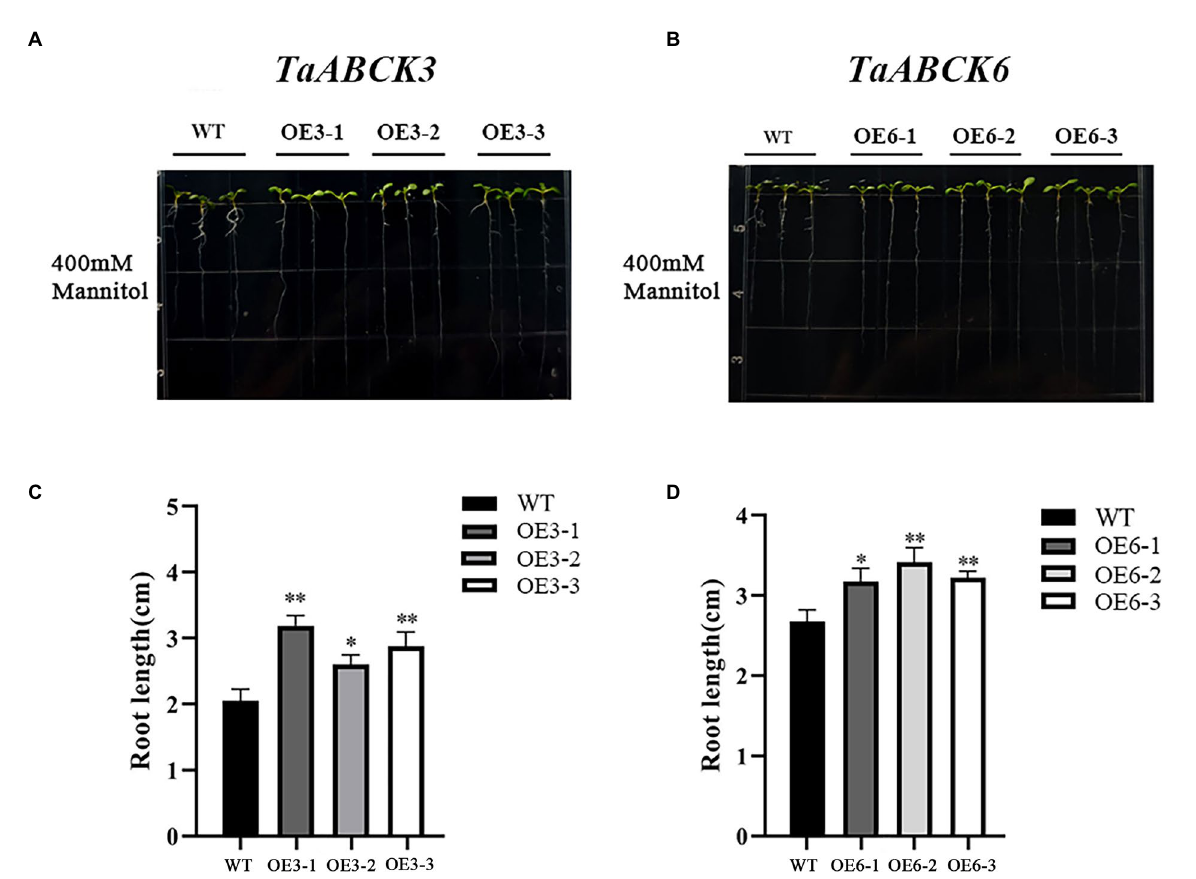
FIGURE 7 Overexpressed of TaABC1K3 and TaABC1K6 enhanced the drought tolerance of Arabidopsis seedlings. Phenotypic changes in wild-type (A) and TaABC1K3 and TaABC1K6 overexpressed seedlings (B) , relative fresh weight of overexpressed Arabidopsis (C) , and wild type (D) are indicated. Mean ± SD of data from three independent biological replicates. Statistically significant differences between wild type and overexpressed plants were calculated by an independent Student’s t -tests: * p < 0.05; ** p <